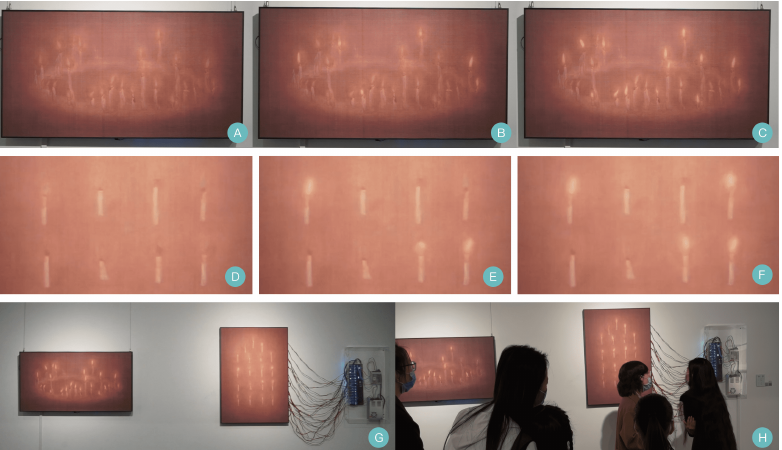
Figure 13. Thermochromic painting “Candle” by ViviPaint displayed in local art museum: ( A – F ) captures of the color-changing process of the two works of “Candle”; ( G , H ) photos of the exhi- bition